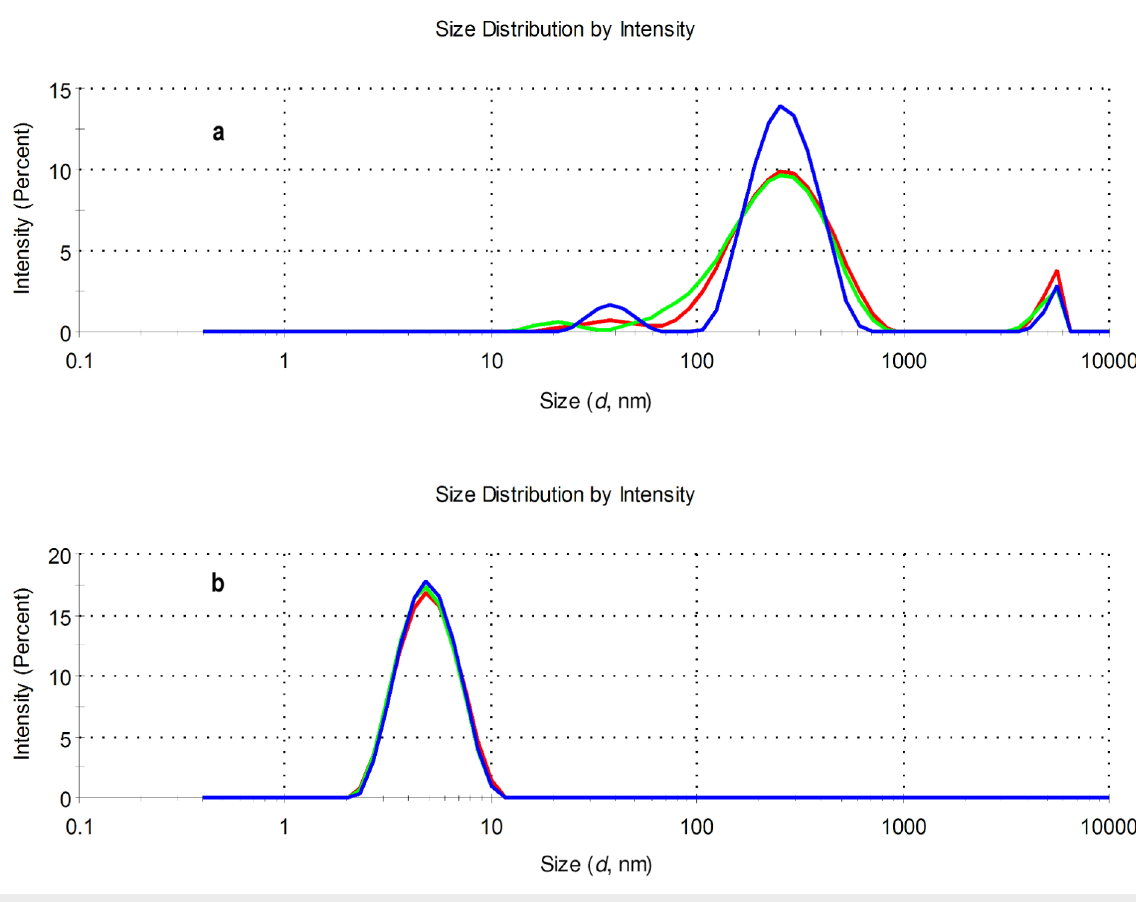
Figure 5: Size distributions of 1 mM aqueous solutions of conjugates 4 – β -CD ( a ) and 2 – β -CD ( b ) at 25.0 °C (pH 7) by intensity (three parallel mea- surements: blue, green and red lines).